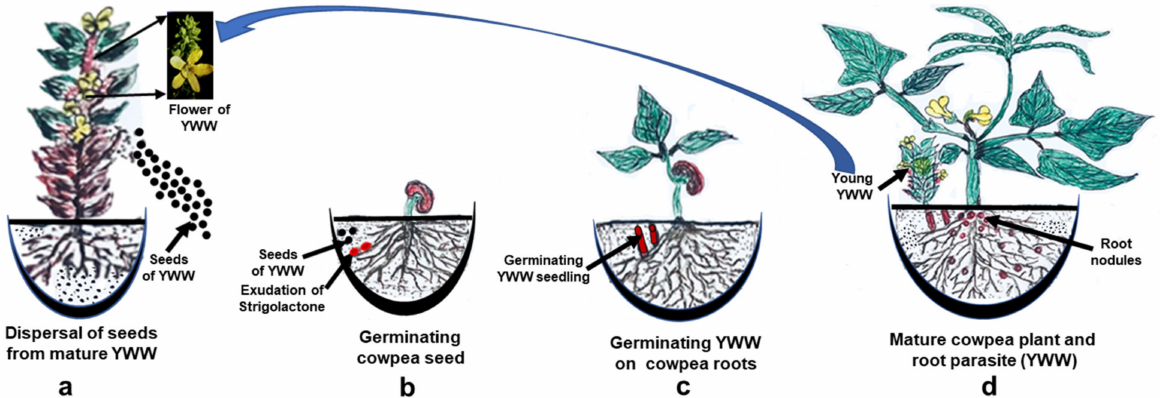
Figure 2. Strigolactone (SL) signal dependent induction of seed germination of root parasite Alectra vogelii (Yellow witch weed, YWW) on Vigna unguiculata L. Walp. (cowpea). ( a ): Release of large number of small sized seeds from mature YWW plant; ( b ): Exudation of SLs by germinating cowpea roots attracting YWW seeds; ( c ): Germinating YW seed (underground portion lacking photosynthetic machinery) on cowpea roots; ( d ): YWW growing as parasite along with cowpea plant. YWW plant on maturity produce a large number of seeds which have very little reserve material and have very low survival